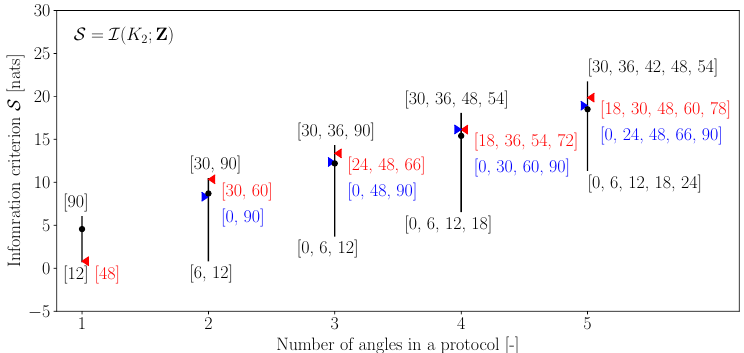
= ( K ) across the 6884 combinations grouped Figure 3. The variation of information criterion 2 ; Z S I by the number of angles in a protocol. The vertical lines represent the variation around the mean value, which is shown in black circles. Black text shows the combinations that produce maximum and minimum values of . The red and blue pointers show for angle combinations that follow a S S uniform discretisation of the angular space between 0 and 90 degrees. Red and blue texts show the associated angle combinations.